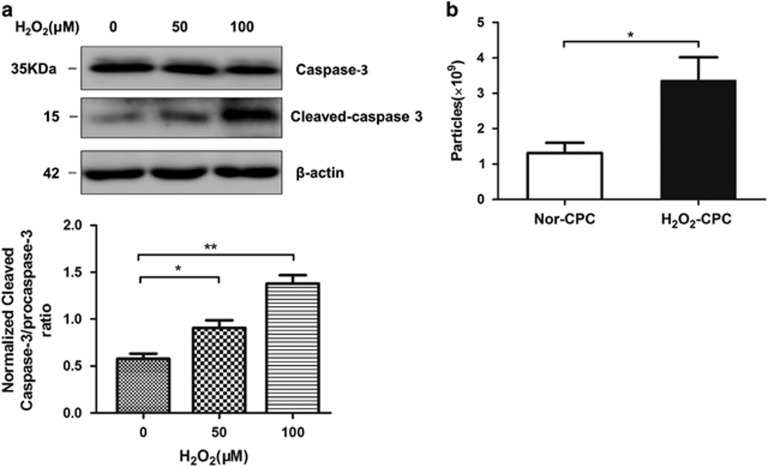
H2O2 affects the cells' apoptosis and exosomes' production. (a) Western blotting analyzed procaspase-3 and cleaved caspase-3 in H9C2 cells after treatment of different H2O2 concentrations (N=3, *P<0.05, **P<0.01 versus 0 μM). (b) NTA counted the production of exosomes derived from normal cultured CPCs (Nor-exo) and exosomes from 100 μM H2O2 treated CPCs (H2O2-exo), H2O2-CPC produce more exosomes ((3.36±0.66) × 109
versus (1.31±0.29) × 109, N=5; *P<0.05 versus Nor-CPC)